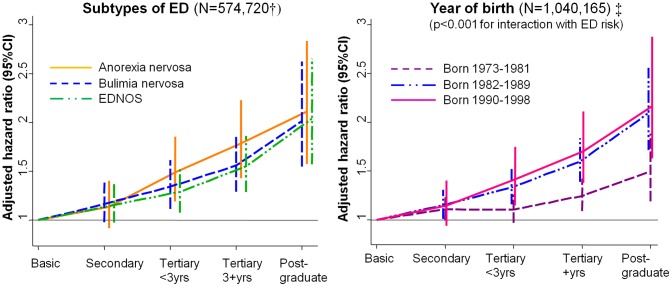
Associations between parental educational level and ED in daughters, comparing associations across ED subtypes and across birth years.CI = confidence interval, ED = eating disorder, EDNOS = eating disorder not otherwise specified. All models adjust for all parent SEP variables (Table 1) plus parental age and the index cohort member's birth year. †Analyses comparing ED subtypes exclude those born before 1985 because the three-way division of these subtypes only became possible in 1997 when ICD-10 was introduced. N = 4362 females for anorexia nervosa; N = 1169 for bulimia nervosa; and N = 4607 for EDNOS. ‡Results very similar if restricted to inpatient diagnoses, which were available across all years for all cohort members.